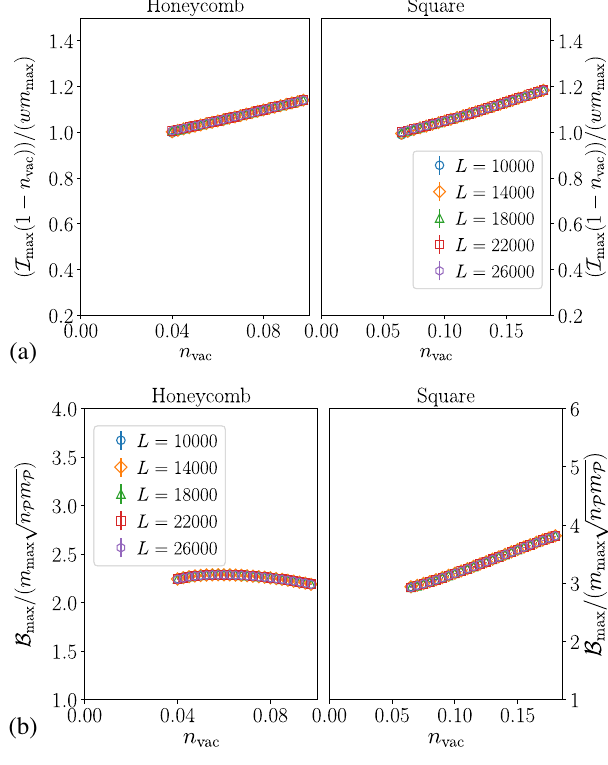
FIG. 22. (a,b) From the sample average of the corresponding ratio on the square and honeycomb lattices, we see that the size B of the boundary of the largest R -type region is proportional, max m ð d − 1 Þ =d n 1 =d with no discernible finite-size corrections, to m P , P max where m is the mass of this region and n P ( m P ) is the total max number (mass) density of P -type regions in the thermodynamic limit in d ¼ 2 dimensions. From the sample average of the corresponding ratio, I , the number of zero modes hosted by max = ð 1 − n Þ , with no the largest R -type region scales with wm max vac discernible finite-size